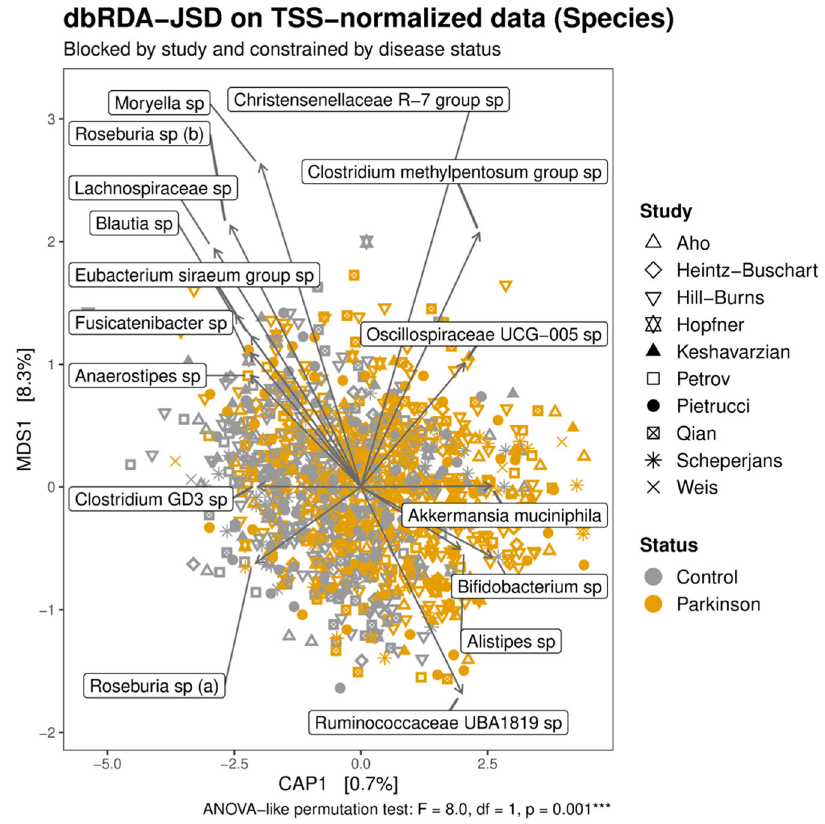
Fig. 4 Most important species driving the divergence of the gut microbiome between PD patients and controls. Distance-based redundancy analysis (dbRDA) was performed on Jensen – Shannon divergence (JSD) calculated on data normalized through total sum scaling (TSS). dbRDA was conditioned (blocked) by study and constrained by disease status. Data refer to species abundances. The limited proportion of data variability explained by the axis constrained for disease status (CAP1) indicates that environmental factors have a major in fl uence in shaping the bacterial communities. However, the in fl uence of the disease status on the community structure is statistically signi fi cant (ANOVA- like permutation test). Only taxa showing a signi fi cant association with the clustering of the samples and the strongest abundance variation between conditions are